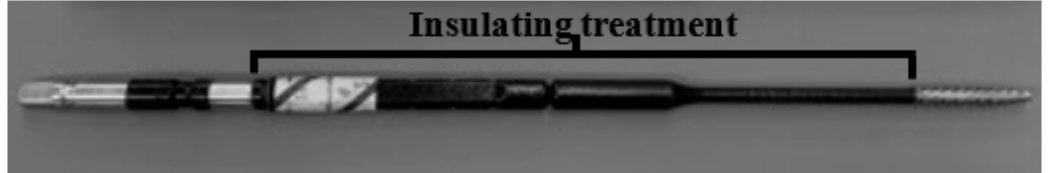
Figure 1. Newly developed insulated coated tap device was used in this study. Table 1. Comparison of the baseline data between two groups.